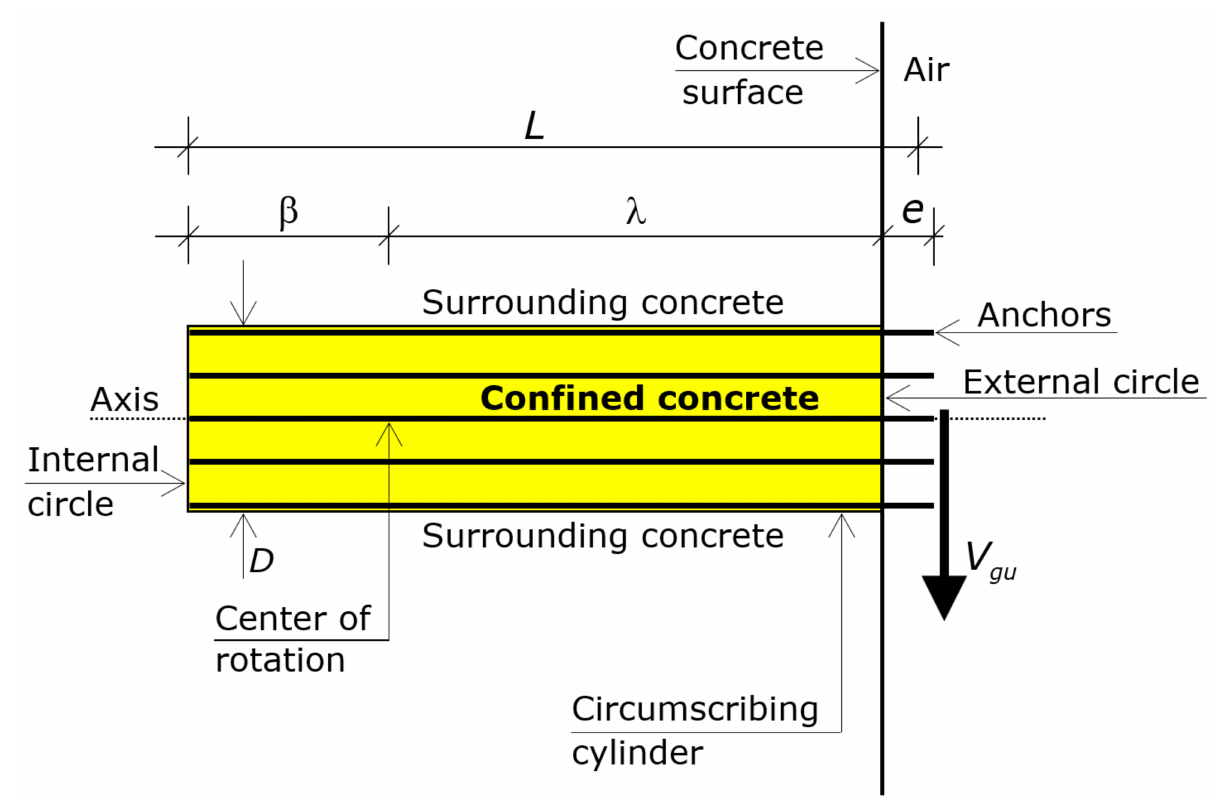
Figure 2. Longitudinal cross-section of the anchor group: circumscribing cylinder (diameter D and height L − e ). The figure shows its lateral surface, which is shadowed, together with its external and internal circles. The figure also shows the anchors (pattern 4-2 of Figure 1) and the center of rotation, which lies on the axis of the cylinder. The concrete within the cylinder is confined. The “surrounding concrete” is the material that dictates the shear strength of the anchor